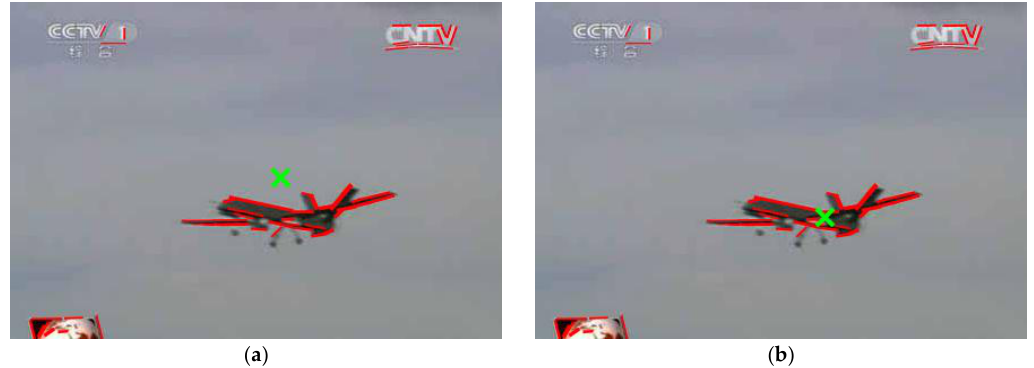
Figure 3. A comparison of the results of the methods: ( a ) Image moment method; ( b ) Mean shift algorithm.